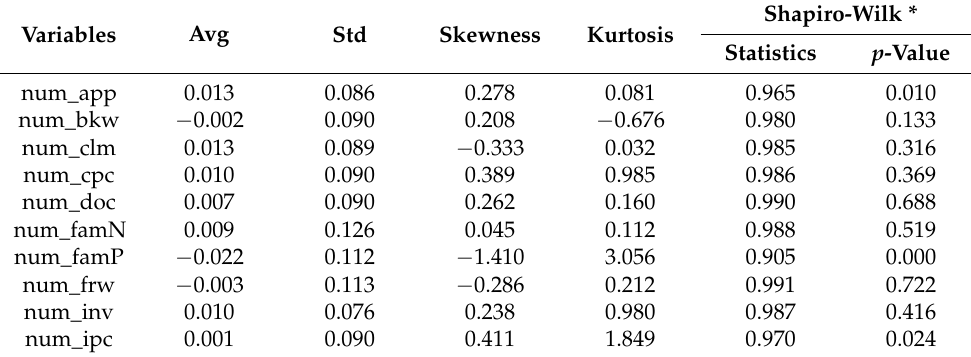
Table 5. Results of statistical test for Hypothesis 2.